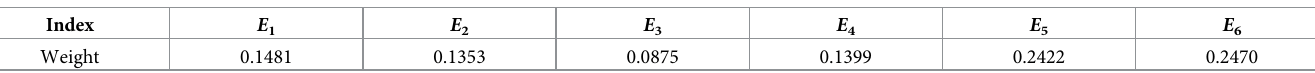
Table 11. Normalized weight vector of final layer of dynamic